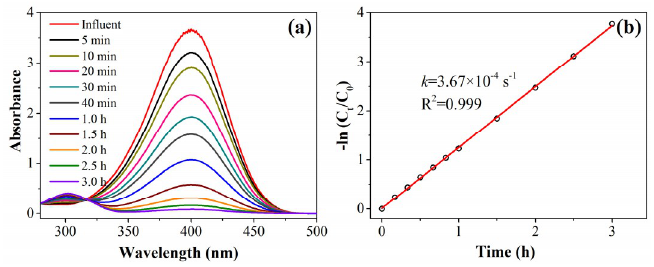
Figure 3. ( a ) Time-dependent UV-Vis absorption spectra and ( b ) rate kinetics of the Au/N-rGO filter (Au/C ratio of 0.2%) catalyzing 4-nitrophenol (4-NP) reduction into 4-aminophenol (4-AP) in a batch reactor system.